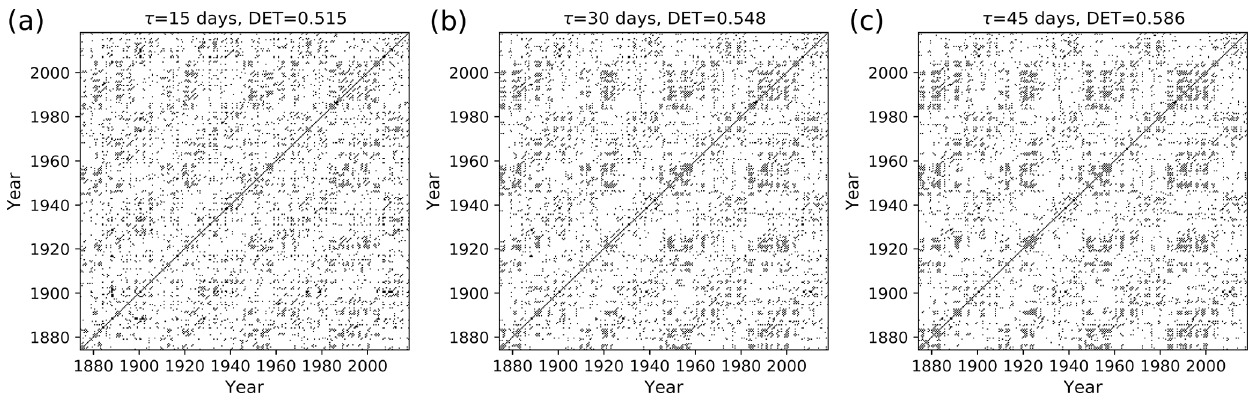
Figure 12. Recurrence plot of flood events using mED, window size = 1 year, with 6 months of overlapping for delays τ = (a) 15d, (b) 30d, and (c)